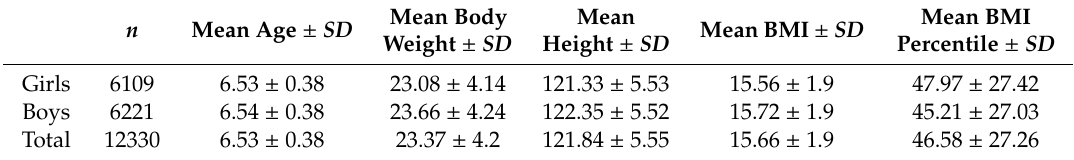
Table 1. Mean age, body weight, height, BMI and percentile BMI in study group (SD- standard